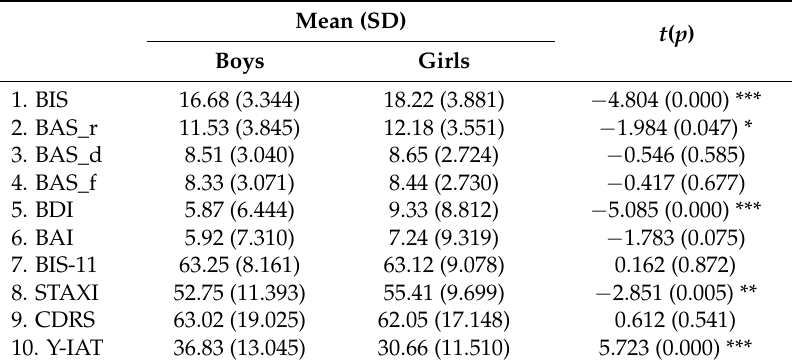
Table 2. Sex differences in overall